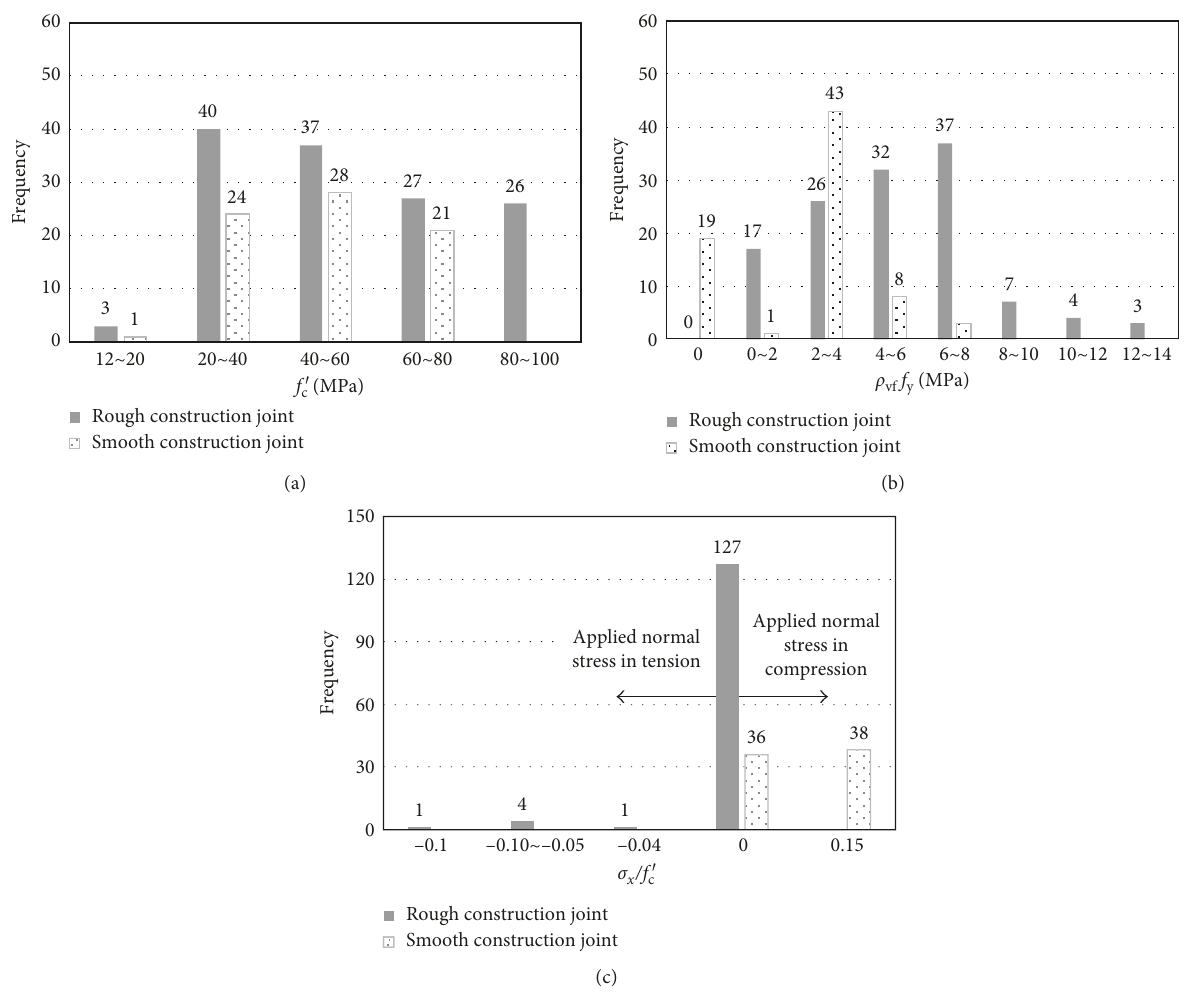
Figure 1: Distribution of different parameters in the 207 push-off specimens with construction joints: (a) compressive strength of concrete ); (b) clamping stress provided by transverse reinforcement ( ρ vf f y ); (c) ratio of applied normal stresses ( σ x ) to f c ( f c ′